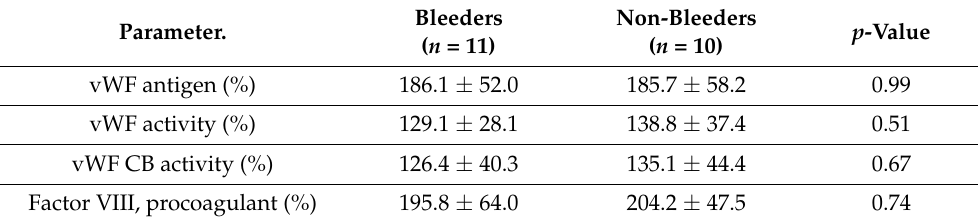
Table 5. Von Willebrand and Factor VIII diagnostics in bleeders and non-bleeders 3 months after LVAD